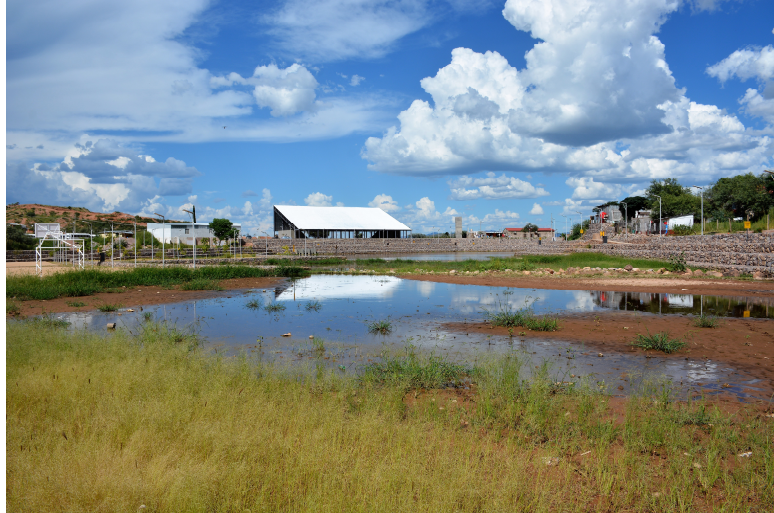
Figure 3. Represo Colosio detention basin in Nogales, Sonora (credit: